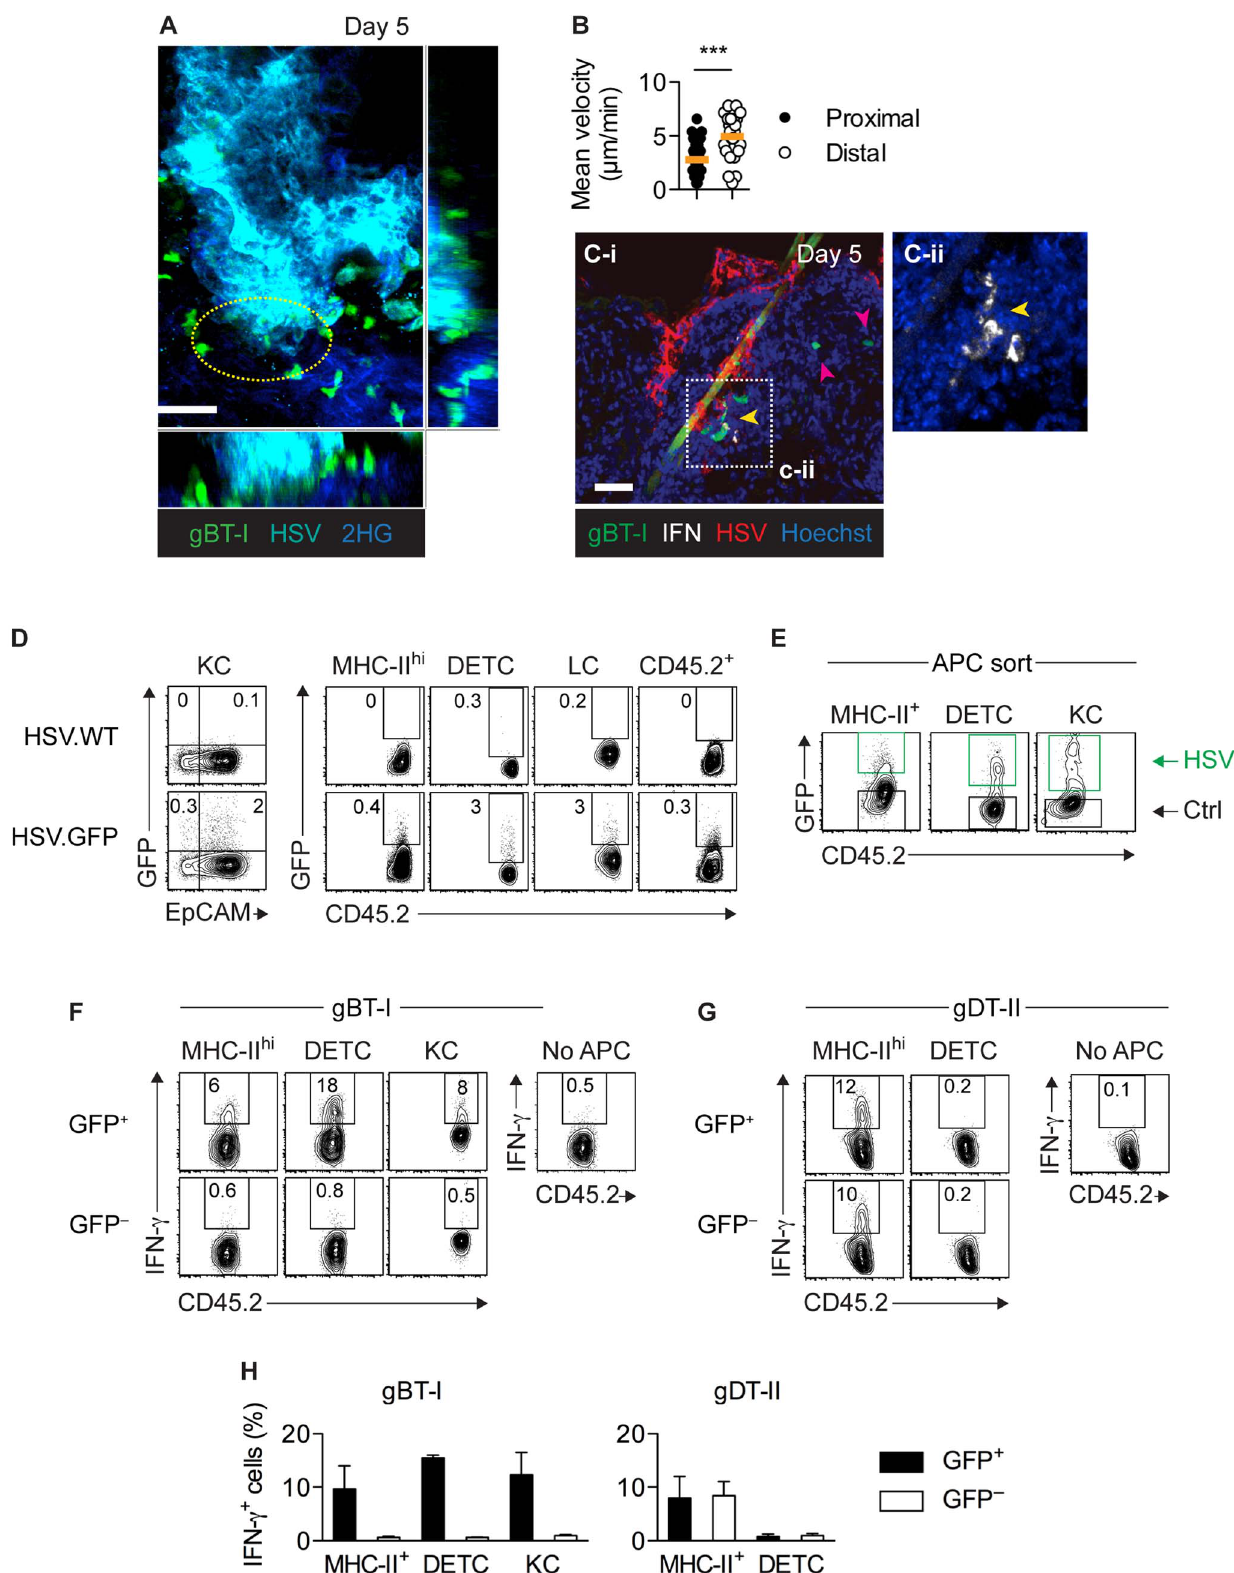
Figure 7. Only directly infected APCs activate CD8 + T EFF cells. ( A , B ) Mice were subjected to skin infection with HSV.CFP and 3 days later received in vitro activated GFP + gBT-I effector cells. Intravital two-photon microscopy of infected skin 5 days post-infection. ( A ) Maximum intensity projection image corresponding to Movie S1 . Yellow circle indicates area with slow moving gBT-I cells. 2HG, second harmonic generation signal; scale bar, 50 m m. ( B ) Mean velocities of gBT-I cells in contact with (Proximal) or distal to (Distal) virus-infected cells from one movie, representative of